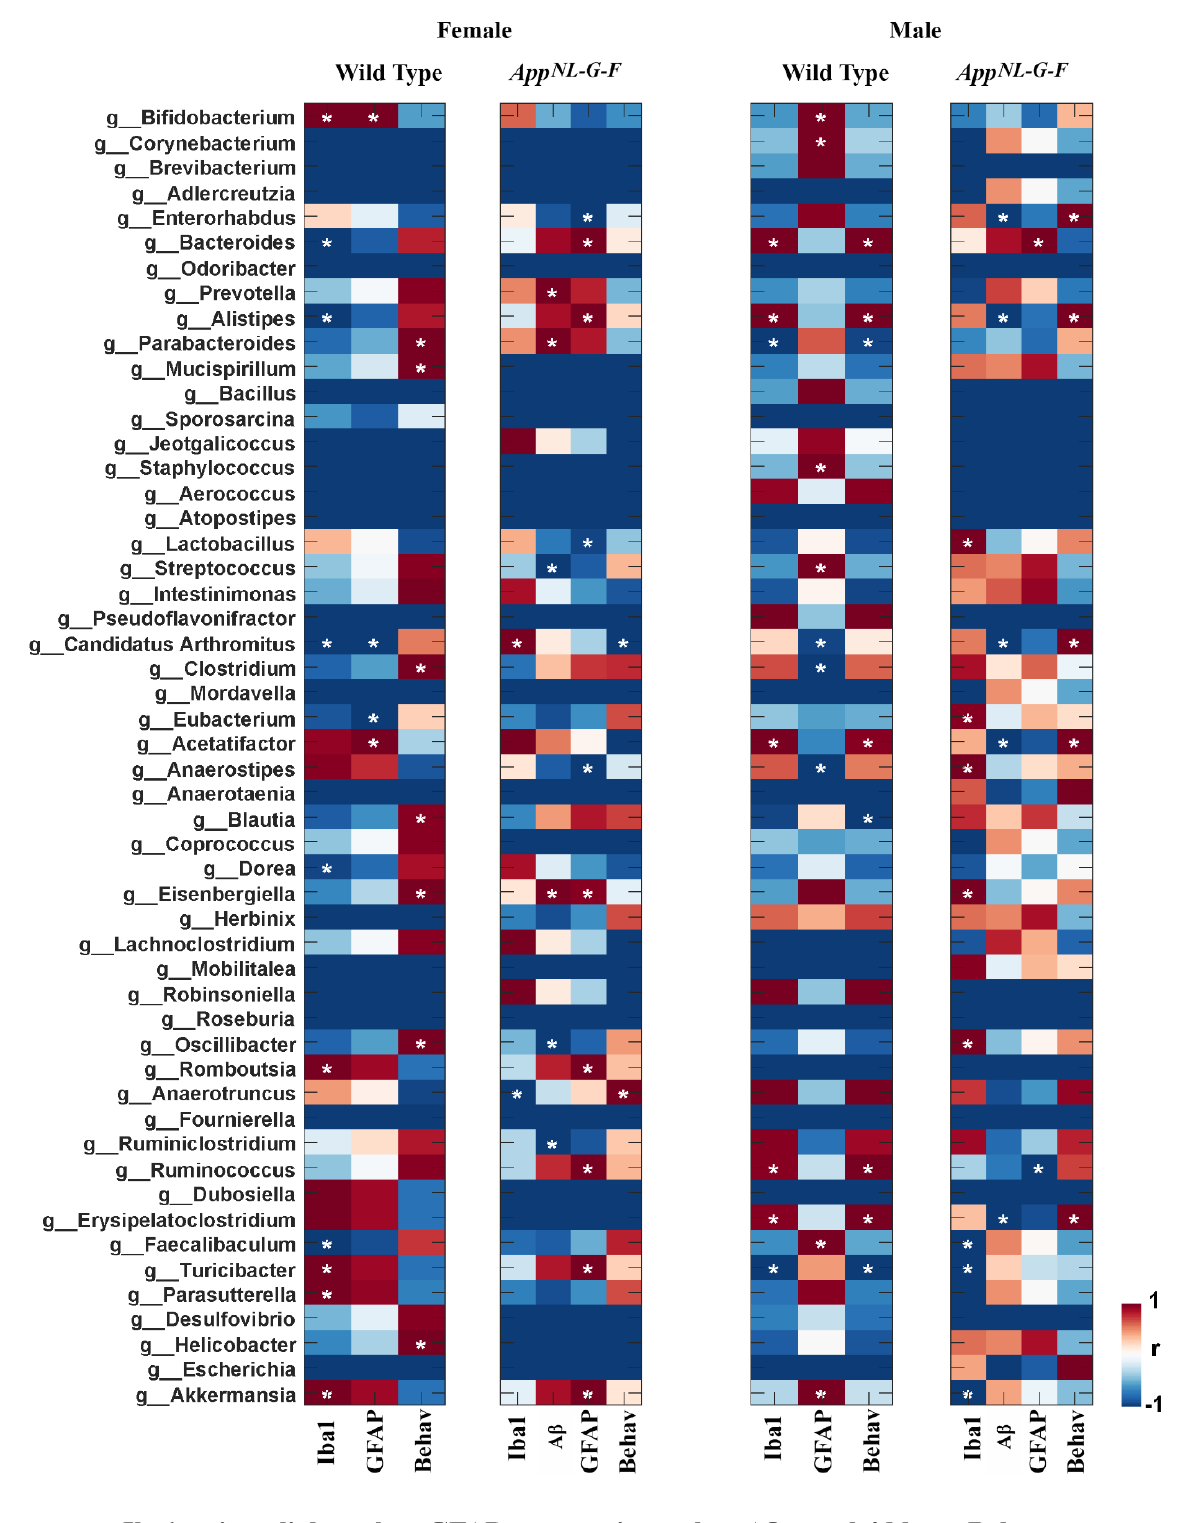
Figure 6. Correlation of A β , behavior, and gliosis with fecal microbiome genera in female and male mice. Heatmaps show the Pearson’s correlation between specific gut genera and brain changes observed in control, probiotic-, and antibiotics- treated groups. Blue to red are r values ranging from negative 1 to positive 1: red color, positive correlation; blue color, negative correlation. The asterisk indicates a significant correlation (more than 95%) between genus and brain data.